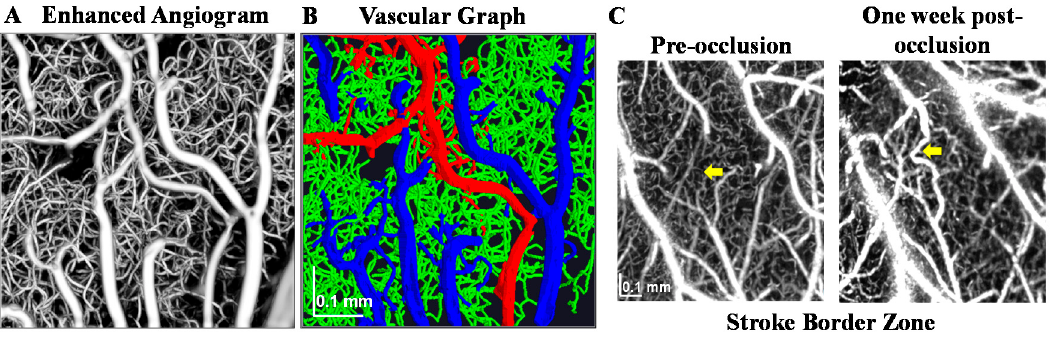
Figure 7. OCTA microscopy of the mouse brain enables an assessment of vascular connectivity ( A , B ) and longitudinal monitoring of microvascular remodeling ( C ) one week after distal middle cerebral artery occlusion (yellow arrow).